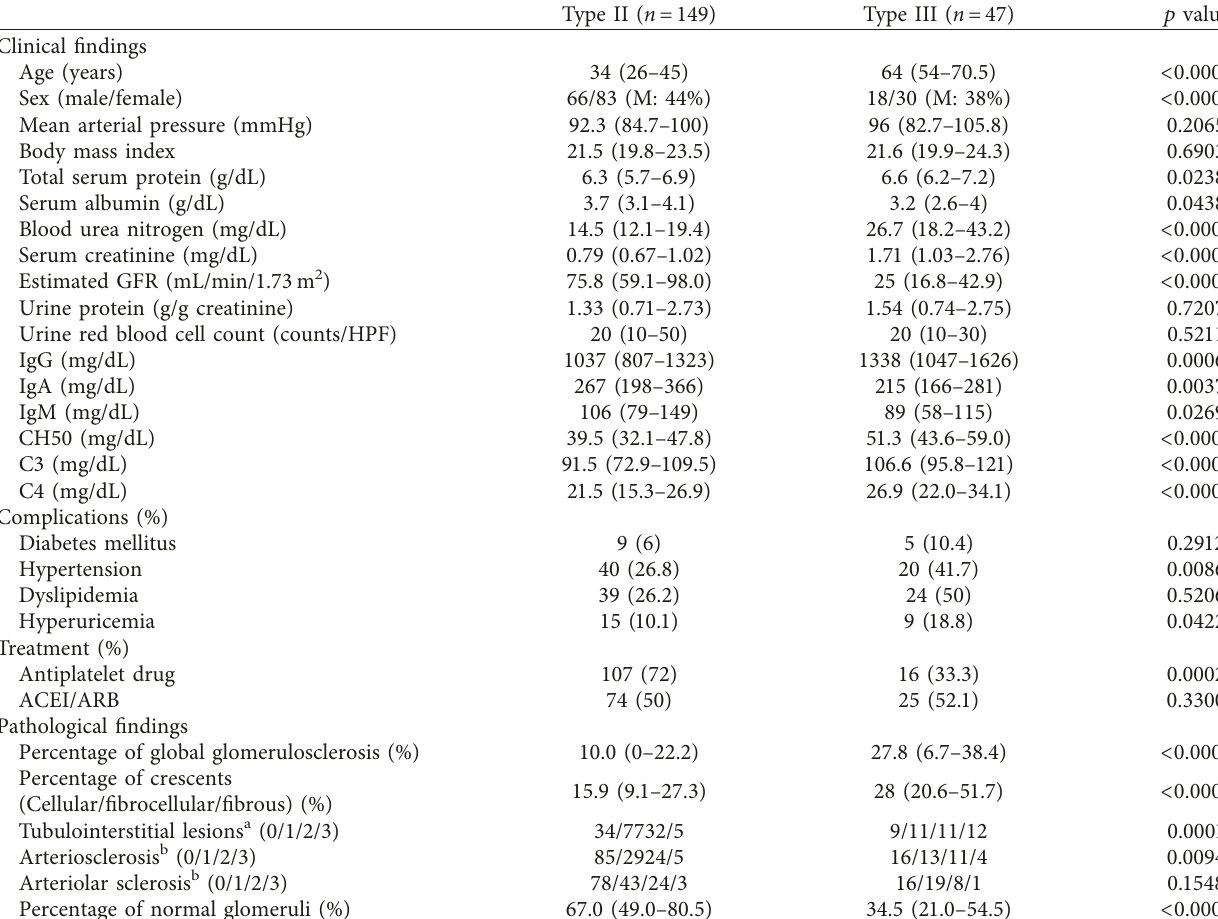
Table 2: Clinical and pathological findings in type II and type III rapid progressive glomerulonephritis at the time of renal